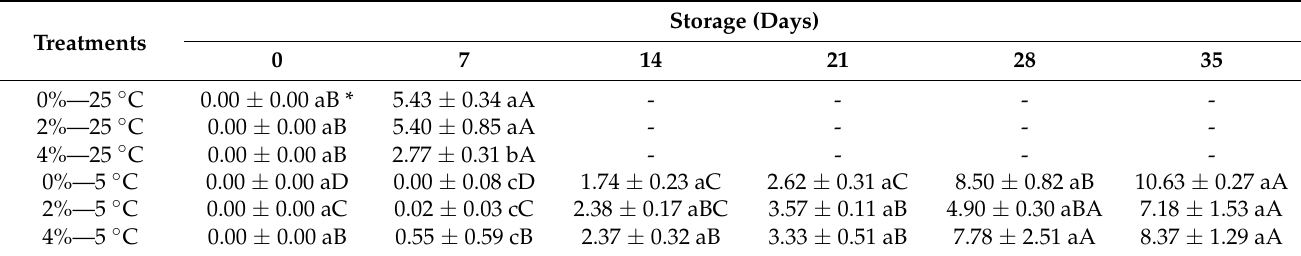
Table 2. Mass loss (%) of plums with different concentrations of edible coating, stored for up to 7 days at 25 ◦ C and 35 days at 5 ◦ C.